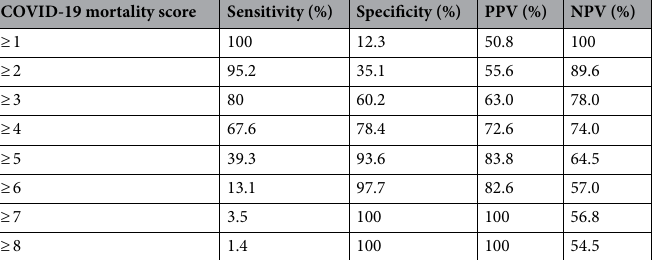
COVID-19 mortality